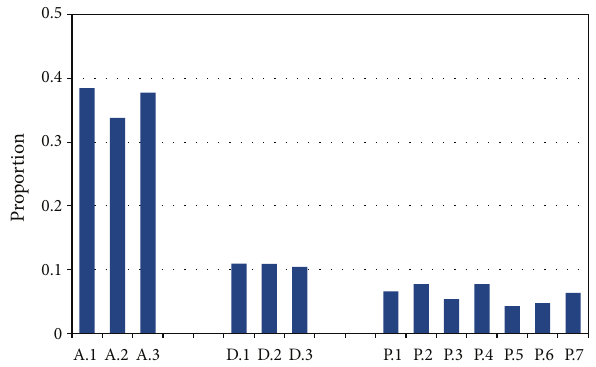
Figure 7: Proportion of ambiguously mapped contigs (before the selection of the best mapping for each contig) in case of experiments on publicly available data